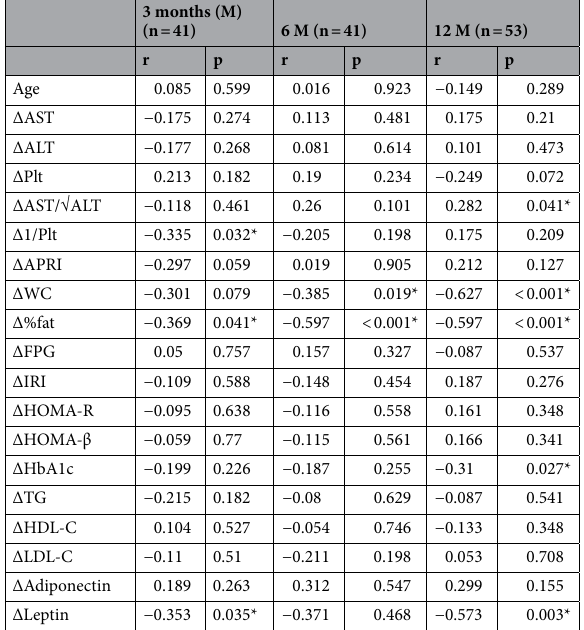
Table 6. Correlations between the amount of weight lost and changes in the platelet count and metabolic parameters. Asterisks indicate a significant difference (p <